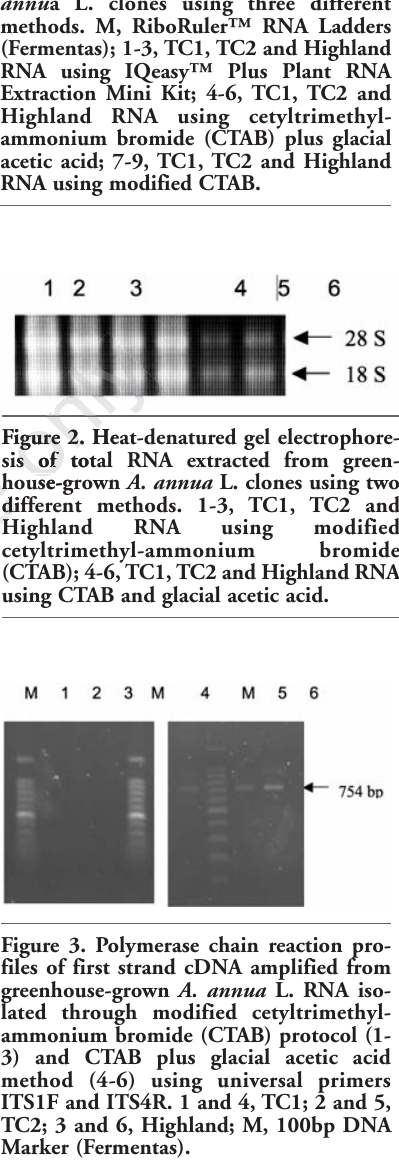
Table 2. Yield of RNA and absorbance ratios from three different greenhouse-grown clones for two different methods of total RNA extraction.